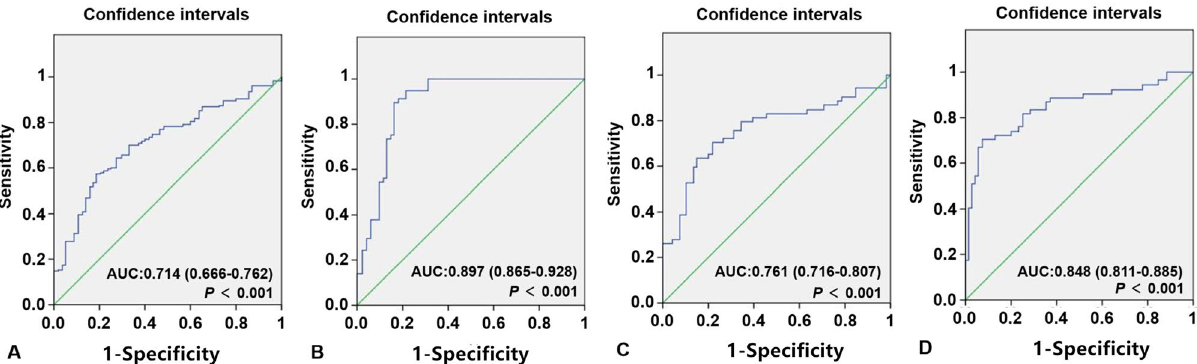
Figure 8. The ROC curves for the predictive values of ITGAM, CAMP, TYROBP and ICAM1 to identify CAD patients from healthy controls. ( A ) The AUC of ITGAM in CAD was 0.714 with a sensitivity of 74.3% and a specificity of 76.2%. ( B ) The AUC of CAMP in CAD was 0.897 with a sensitivity of 81.2% and a specificity of 91.1%. ( C ) The AUC of TYROBP in CAD was 0.761 with a sensitivity of 77.1% and a specificity of 79.7%. ( D ) The AUC of ICAM1 in CAD was 0.848 with a sensitivity of 83.3% and a specificity of 86.7%.